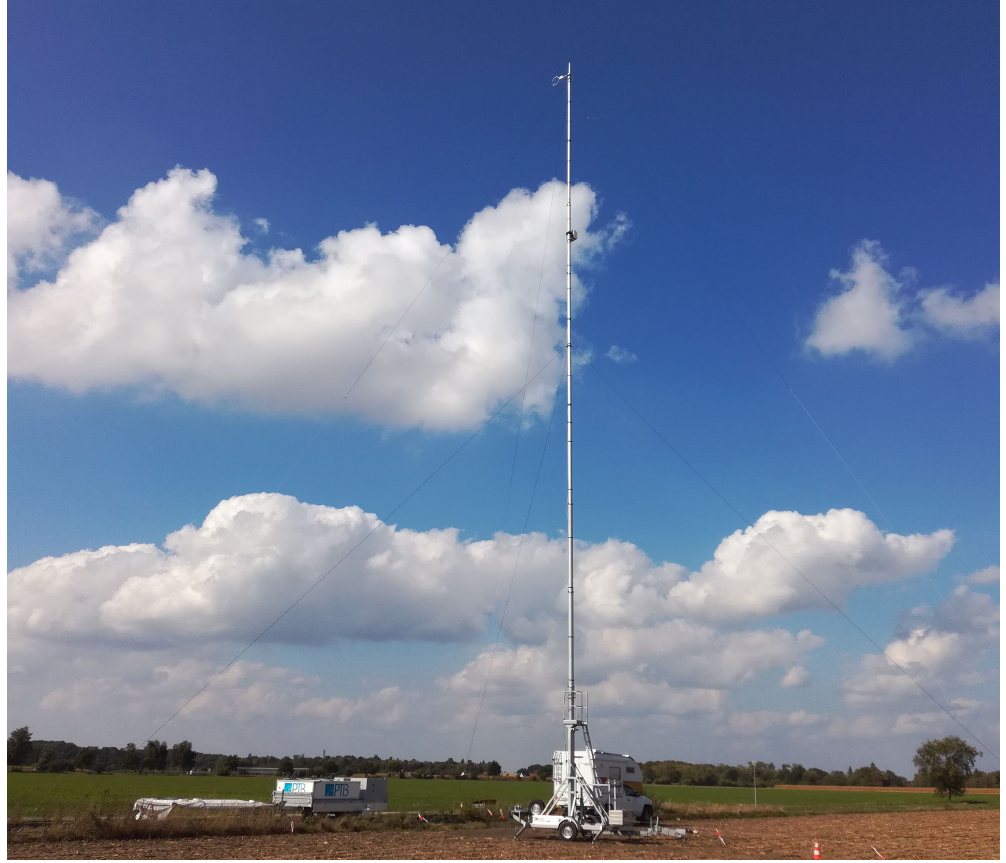
Figure 3. Photograph of the setup of the field intercomparison experiment between the bistatic PTB lidar (left) and the CSAT3B mounted on a mobile 30m telescopic mast (centre right). The camera is facing